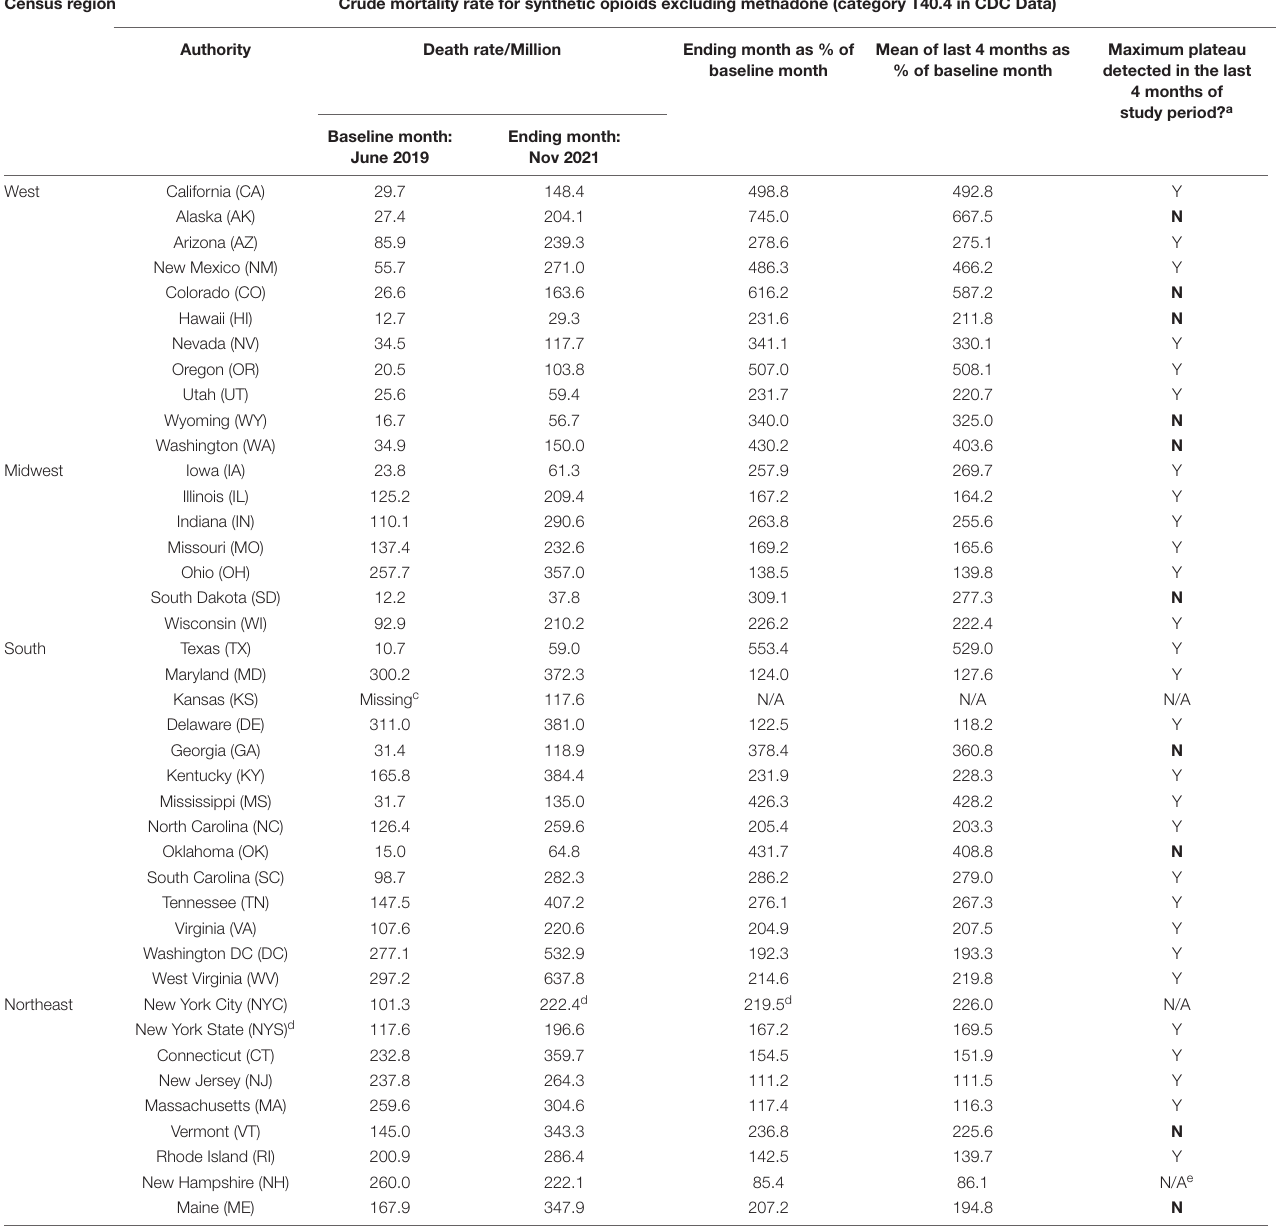
TABLE 1 | Mortality rate for overdoses caused by synthetic opioids, before and after the onset of COVID-19. Census region Authority Death rate/Million Ending month as % of